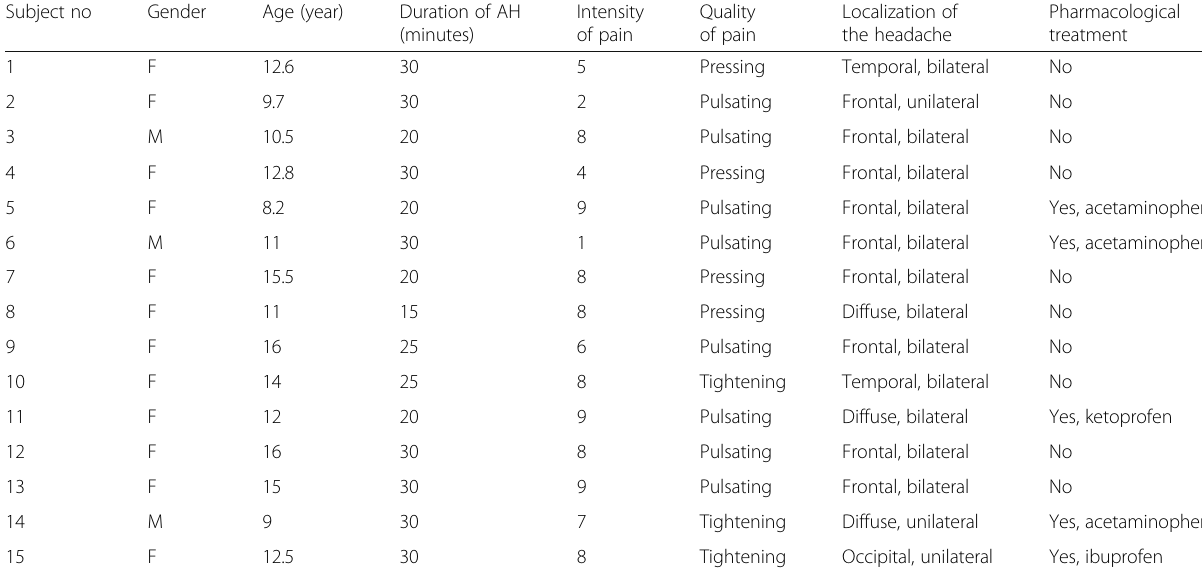
Table 4 Demographic characteristics and clinical reports of the AH